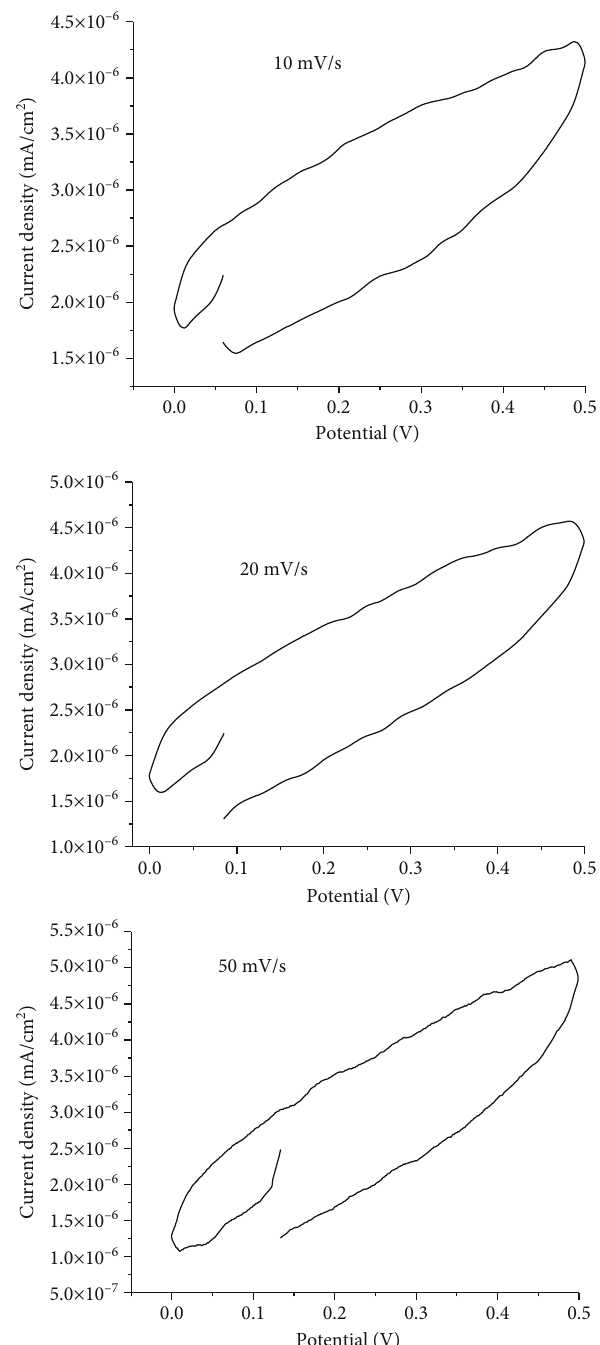
Figure 13: CV curves for the device with dielectric paper at di ff erent scan rates.